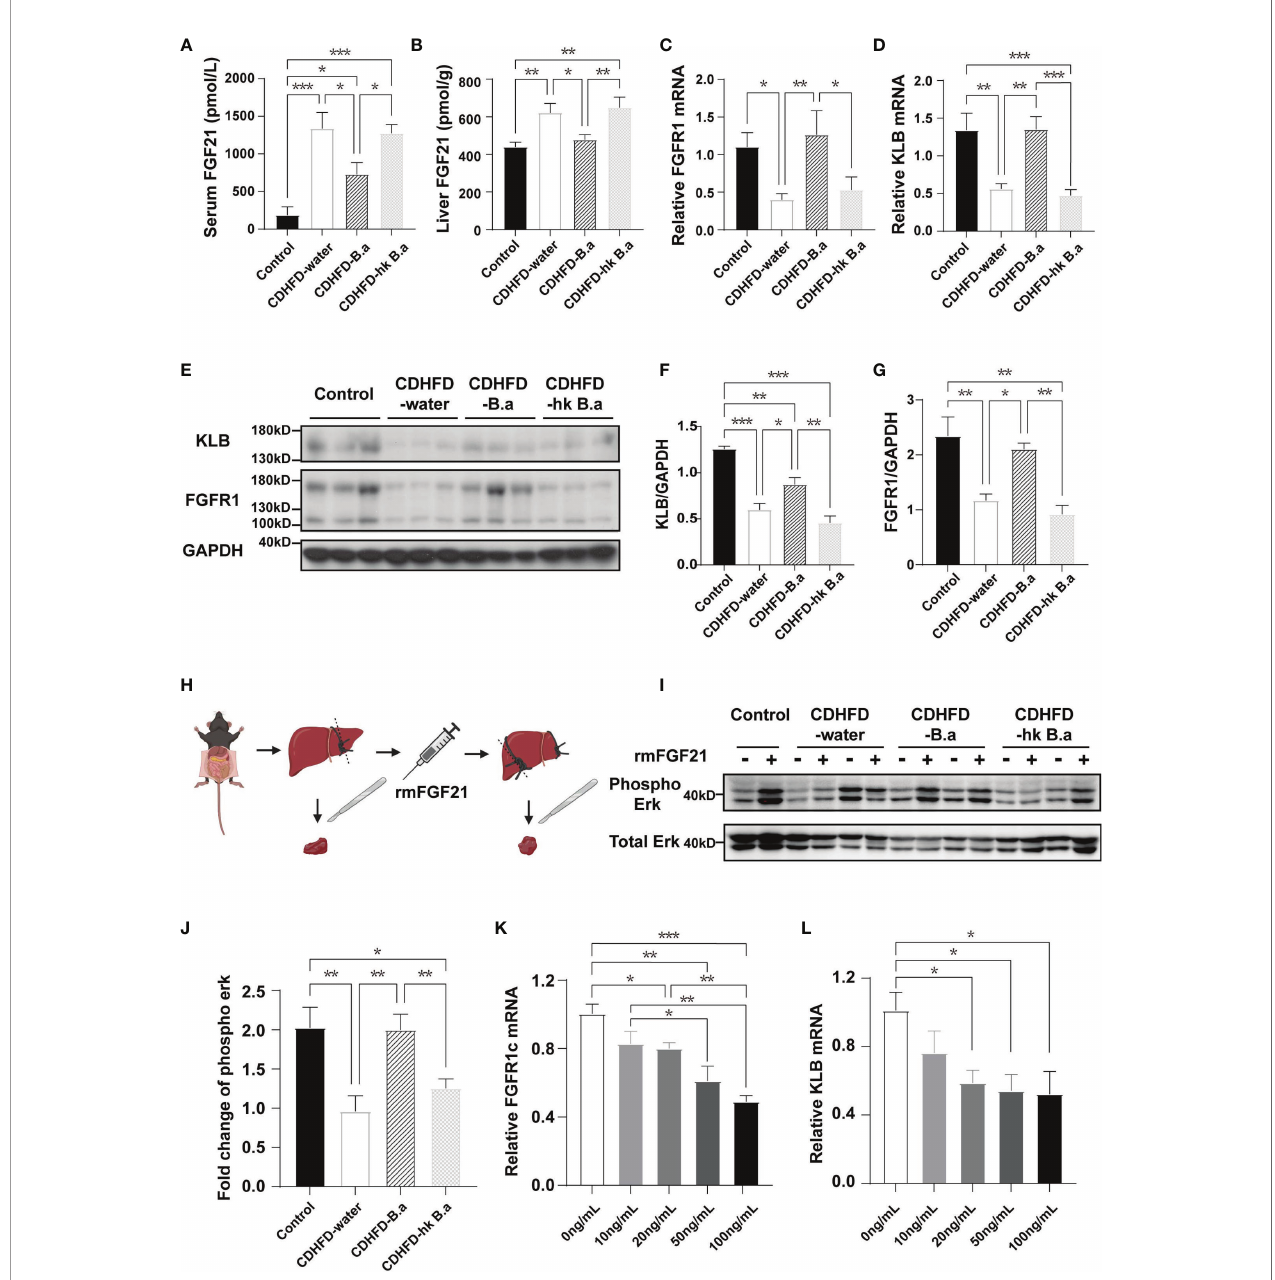
FIGURE 4 | B. adolescentis supplementation alleviated FGF21 resistance. Mice were grouped and treated as in Figure 1 . (A) The serum level of FGF21 (n = 6 in each group). (B) FGF21 levels in liver measured by ELISA (n = 6 in each group). (C) The transcription of FGFR1 in liver (n = 6 in each group). (D) The transcription of KLB in liver (n = 6 in each group). (E) The expression of FGFR1 and b -Klotho in liver detected by western blot analysis. (F) Quanti fi cation of the FGFR1 expression normalized to GAPDH (n = 3). (G) Quanti fi cation of the KLB expression normalized to GAPDH (n = 3). (H) Experiment schematics for FGF21 response test. The experiment schematic was created using BioRender.com. (I) Phosphorylation of Erk1/2 (Thr202/Tyr204) before and after rmFGF21 administration (2mg/kg) detected by western blot analysis. (J) Quanti fi cation analysis of the fold change of Erk1/2 phosphorylation (n = 4-6). FGF21, fi broblast growth factor; FGFR1, Fibroblast growth factor receptor 1; GAPDH, glyceraldehyde-3-phosphate dehydrogenase; KLB, b -klotho; rmFGF21, recombinant mouse fi broblast growth factor 21. (K) The transcription of FGFR1 in hep1-6 after the treatment with LPS. (L) The transcription of KLB in hep1-6 after the treatment with LPS. Data are presented as mean ± SEM. Signi fi cance was determined by one-way ANOVA with Fisher ’ s LSD multiple-comparison analysis. *p < 0.05; **p < 0.01; ***p <